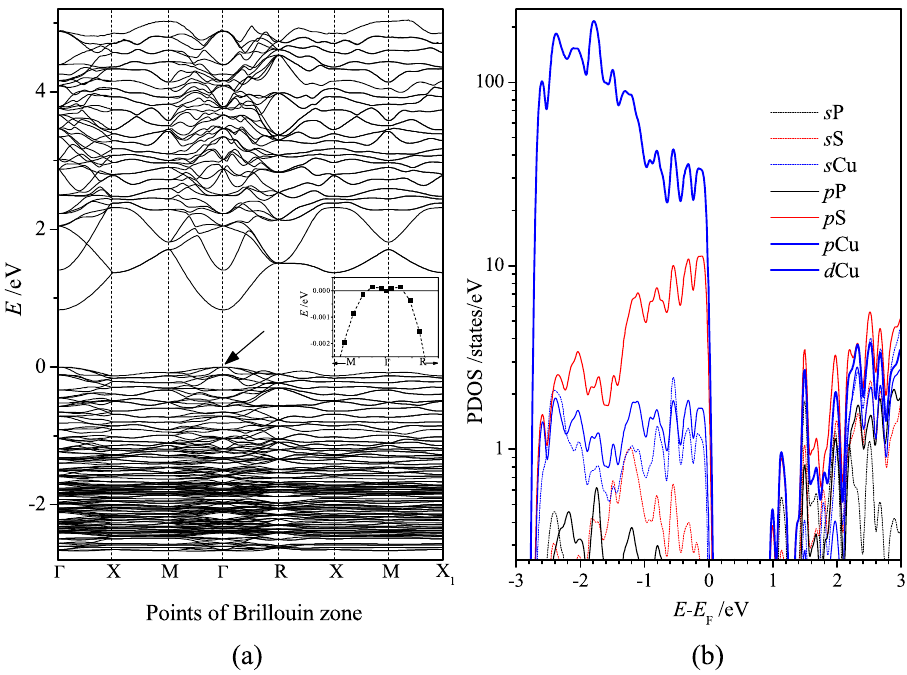
Figure 2. Band structure ( a ) and partial density of states ( b ) of Cu 7 PS 6 for the symmetry space group no. 198 at the points Γ—000, X—010, M—½½0, R—½½½, X1—100 of BZ. The highest energy of the top valence band is placed at E = 0 eV. In the inset of ( a ), the enlarge E ( k ) dependence of the top valence band no. 236 (v236) in the vicinity of Γ-point (shown by